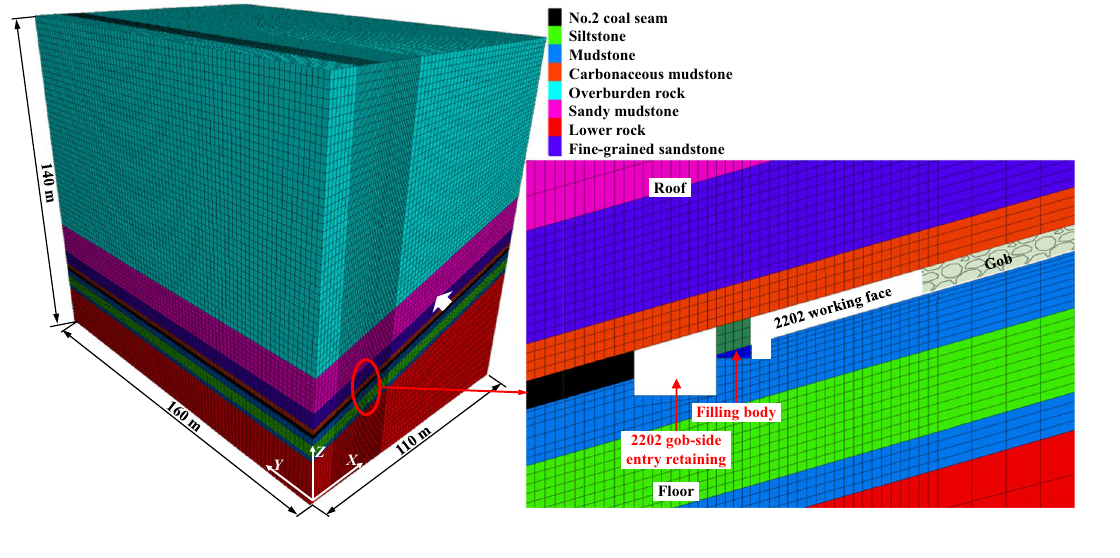
Fig. 10 Numerical model Table 2 Mechanical parameters of each coal and rock stratum Lithology